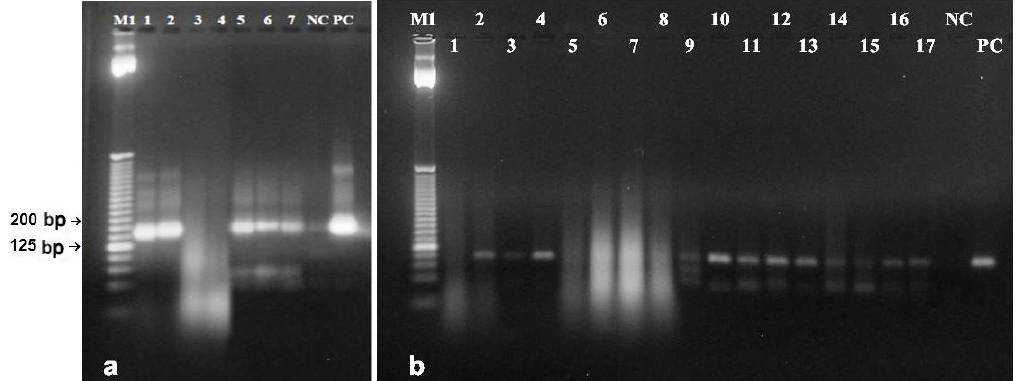
Figure 5. Amplification of 156 bp microsatellite psSSR69 in DNA extracted from the poppy seed filling ( a ) using: Bayer BioScience N.V. [25] (lane 1), QIAamp DNA Stool Mini Kit (2), newly developed protocol (3, 5, 7), Monsanto Company [26] (4, 6) NC—negative control, PC—positive control. Lanes 1–4 represent samples without, lanes 5–7 with purification through silica membrane columns. Amplification of 96 bp fragment of the reference tubulin gene ( b ) using: Bayer BioScience N.V. [25] (lanes 1, 2, 9, 10), QIAamp DNA Stool Mini Kit (lanes 3, 4, 11, 12), newly modified protocol (lanes 5–7, 13–16),